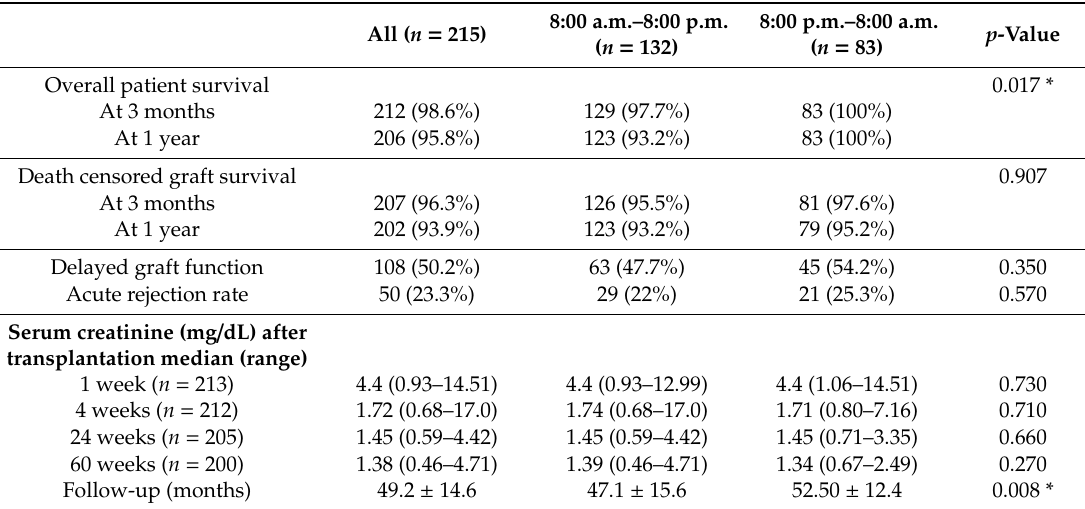
Table 2. Graft and recipient outcome, * statistically